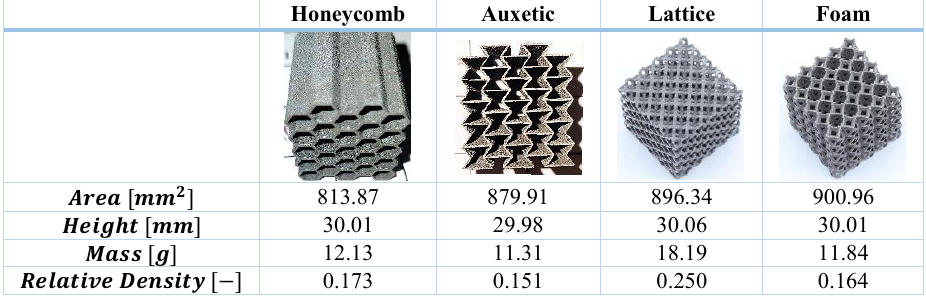
Table 1. The tested structures and their geometrical properties. Honeycomb Auxetic Lattice